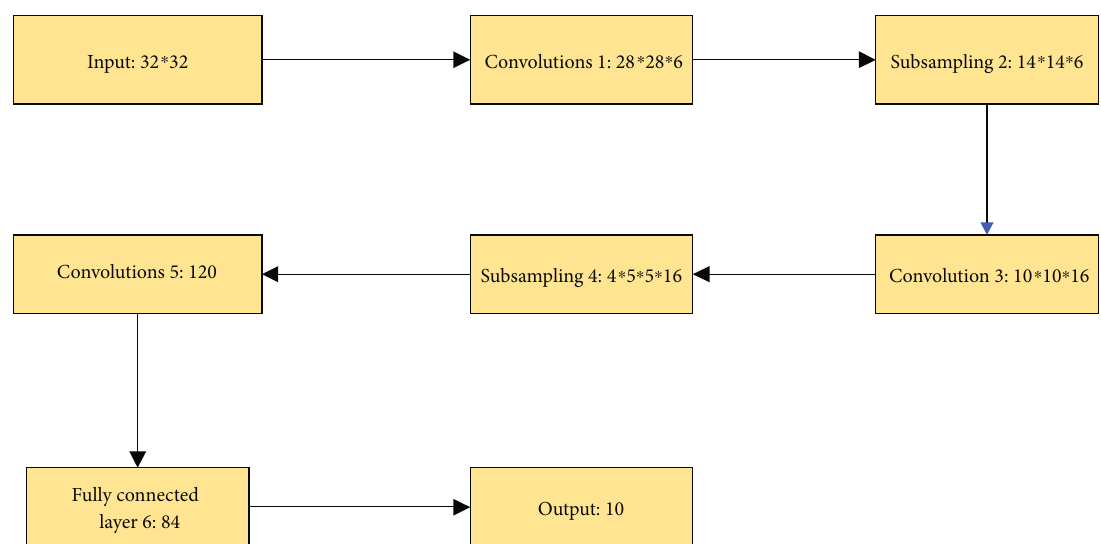
Figure 5: ConvNet network architecture